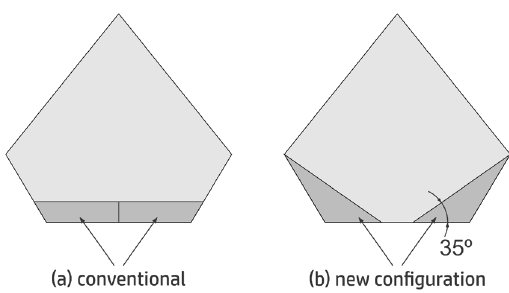
Figure 12. Conventional configuration ( a ) with control surfaces modified with an angle of 35